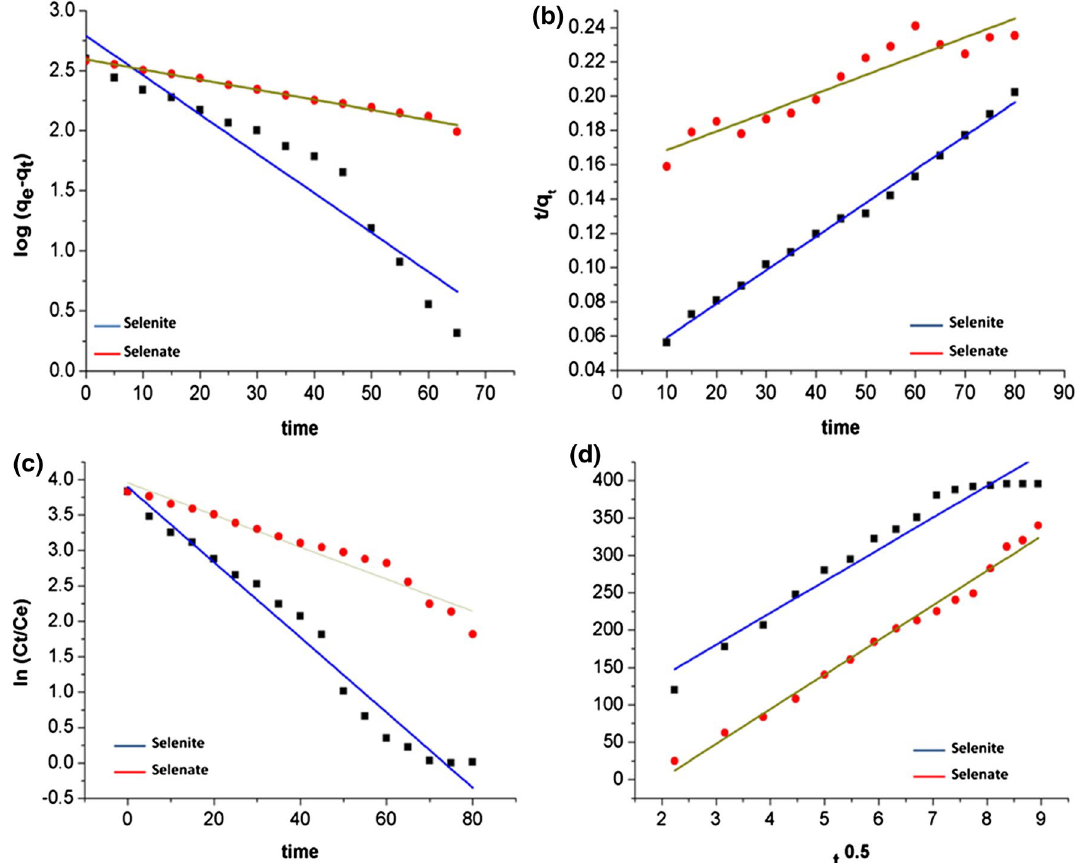
Fig. 4 Kinetics isotherms (volume 500 ml, temperature 30 ± 2 °C, initial Se concentration 200 µg L −1 , adsorbent dose 0.5 g L −1 for sel- enite and 2.0 g L −1 for selenate). a Pseudo-first-order plot for selenite and selenate adsorption. b Pseudo-second-order plots for selenite and